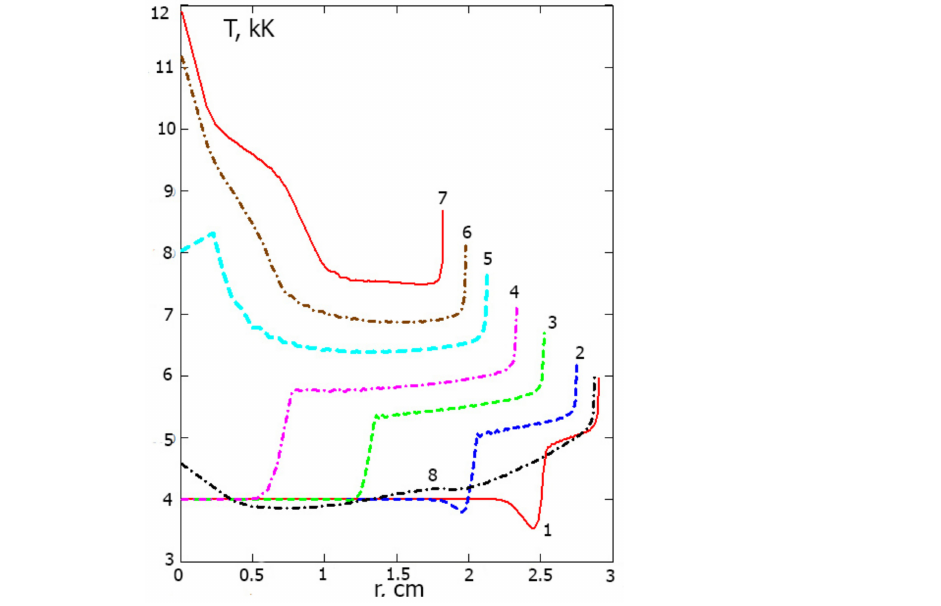
Figure 4. Temperature distributions of plasma compressed by a copper sheath; t , ns: 1–50, 2–80,